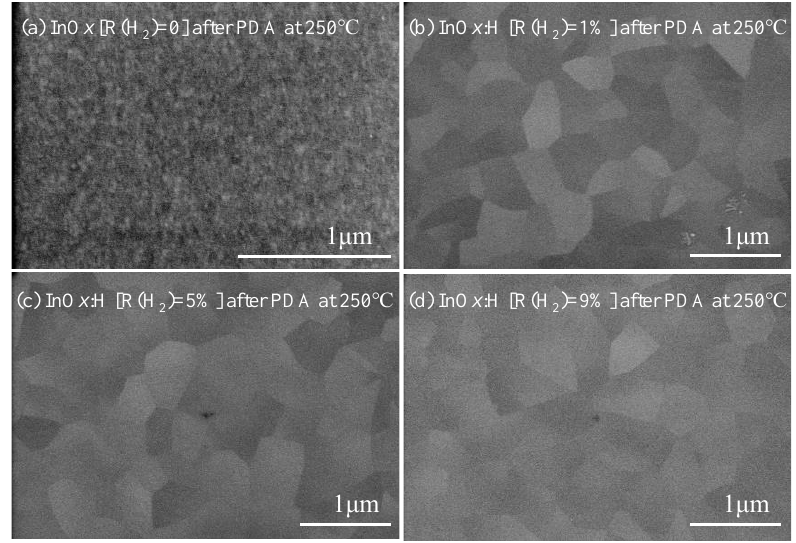
Figure 3. SEM surface views of ( a ) poly-InO x [R(H 2 ) = 0] and poly-InO x :H [R(H 2 ) = ( b ) 1, ( c ) 5, and ( d ) 9%] films after PDA at 250 °C.